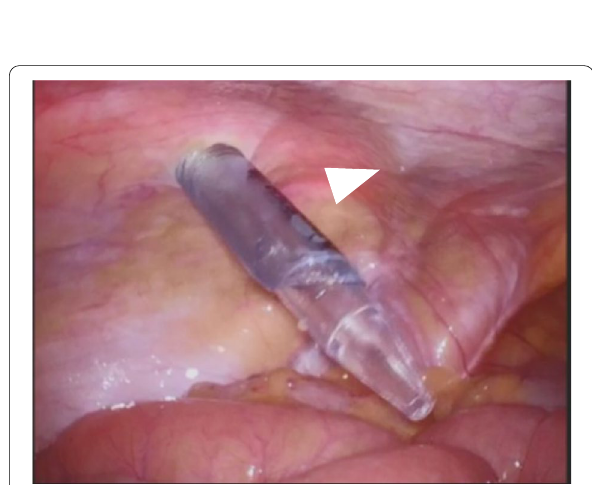
Fig. 6 Intraoperative port insertion finding. The port is inserted avoiding the inferior epigastric artery. The white arrowhead shows an epigastric